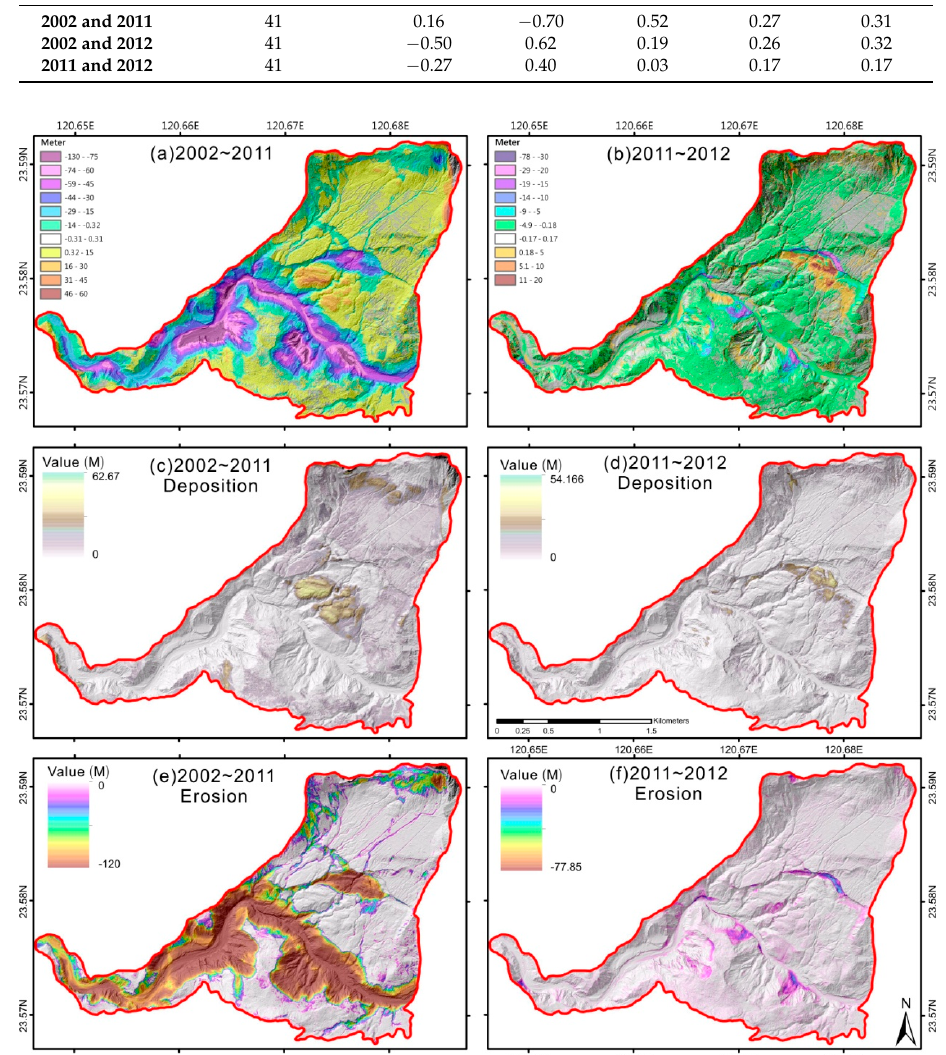
Figure 8. Terrain changes between 2002–2011 and 2011–2012 calculated based on the three-period ALS DEM data: ( a , b ) The terrain elevation change diagrams between 2002–2011 and 2011–2012, respectively. The color represents the value of geomorphological change. More specifically, the cool colors represent a decrease in terrain elevation because of erosion, whereas warm colors represent an increase in terrain elevation due to debris accumulation. ( c , d ) The increased area of the DEM terrain elevation during 2002–2011 and 2011–2012, respectively, due to the accumulation effect. ( e , f ) The decreased area of DEM terrain elevation during 2002–2011 and 2011–2012, respectively, due to the erosion effect.